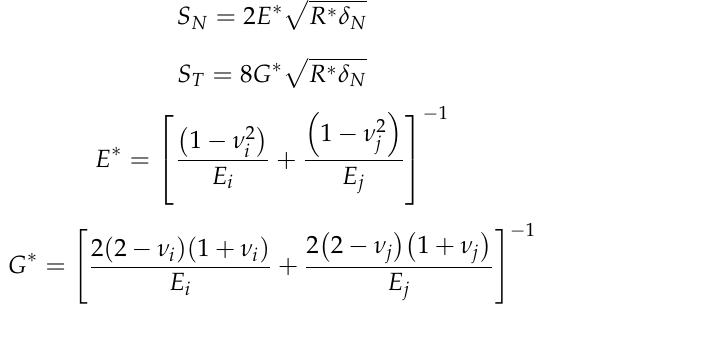
where S N and S T are the normal stiffness and tangential stiffness of particles, respectively; E * , G * , R * , and m * are the equivalent Young’s modulus, shear modulus, radius, and mass of particles, respectively. The expressions are shown in Equations